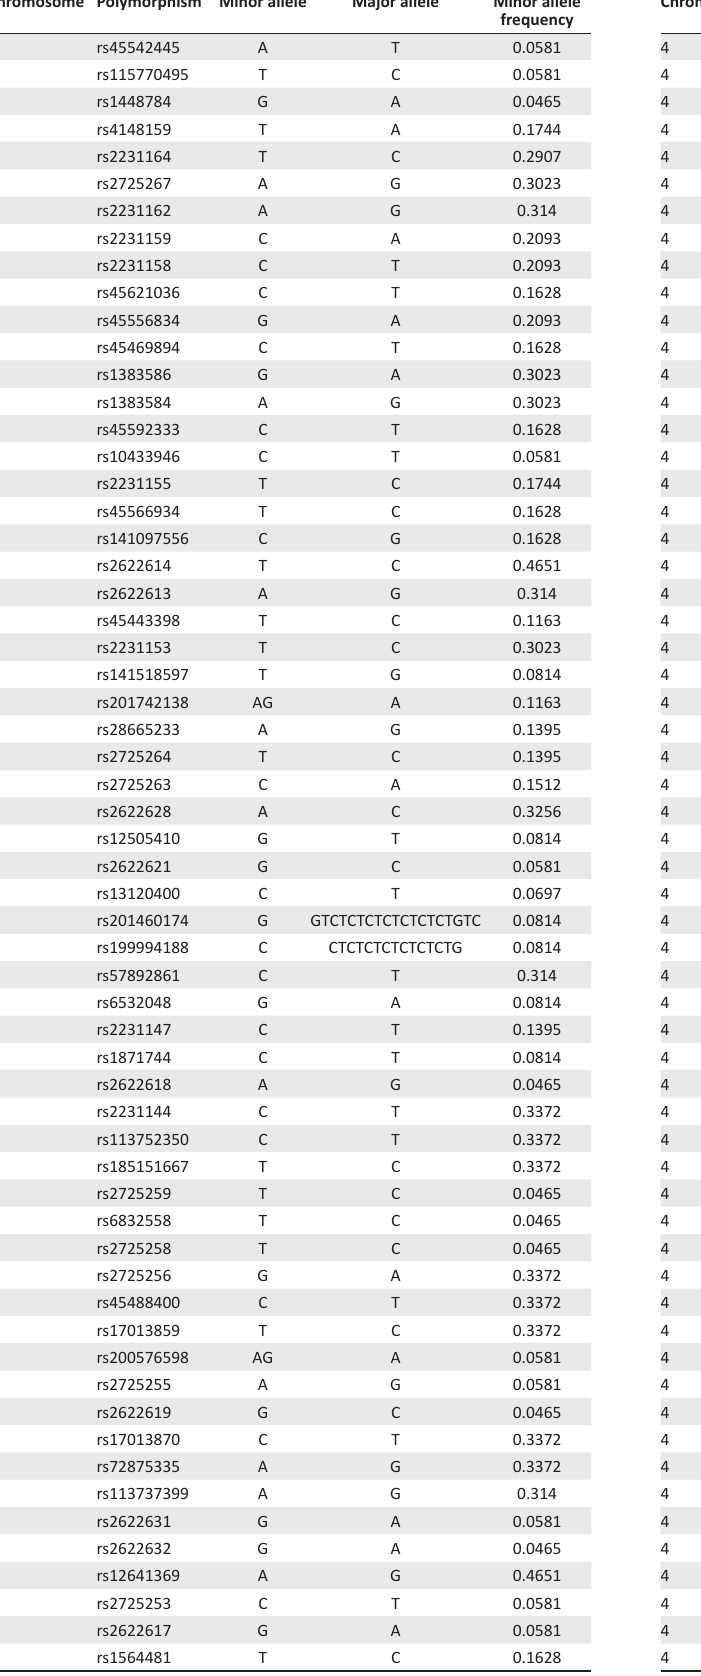
Table 1-A1 continues on the next page →Table 1-A1 continues in the next column